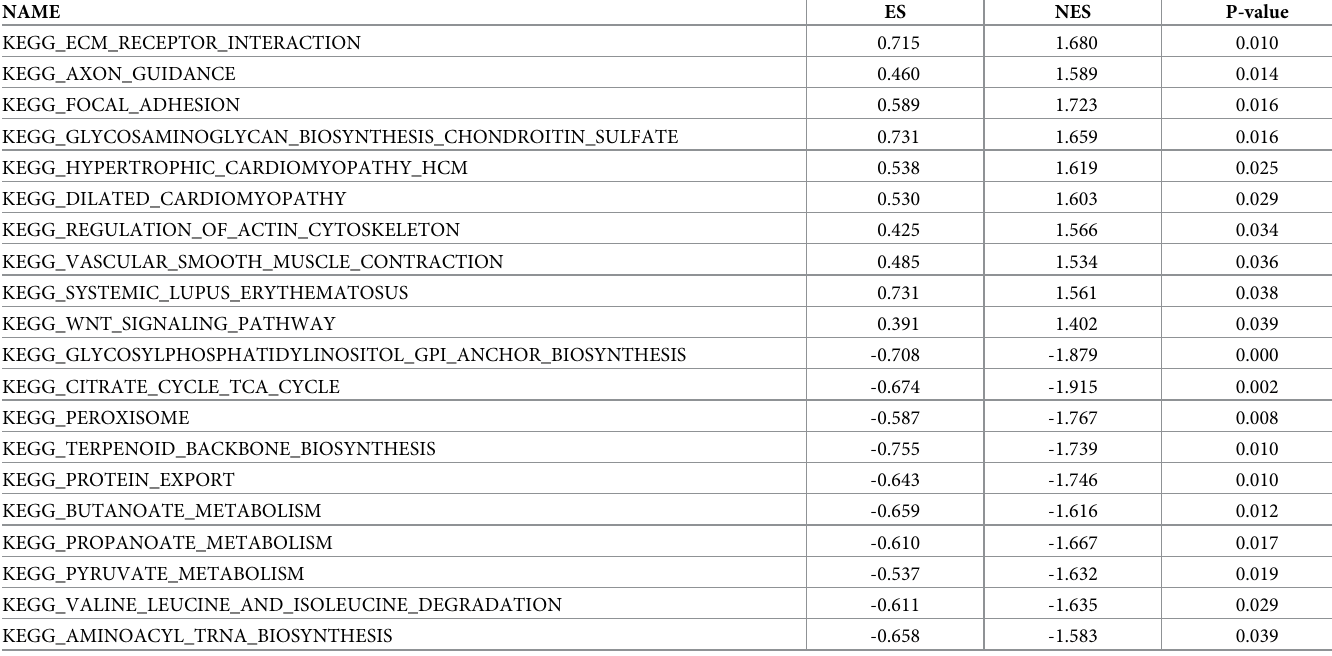
Table 5. GSEA enrichment analysis results in the GSE39582 cohort (top